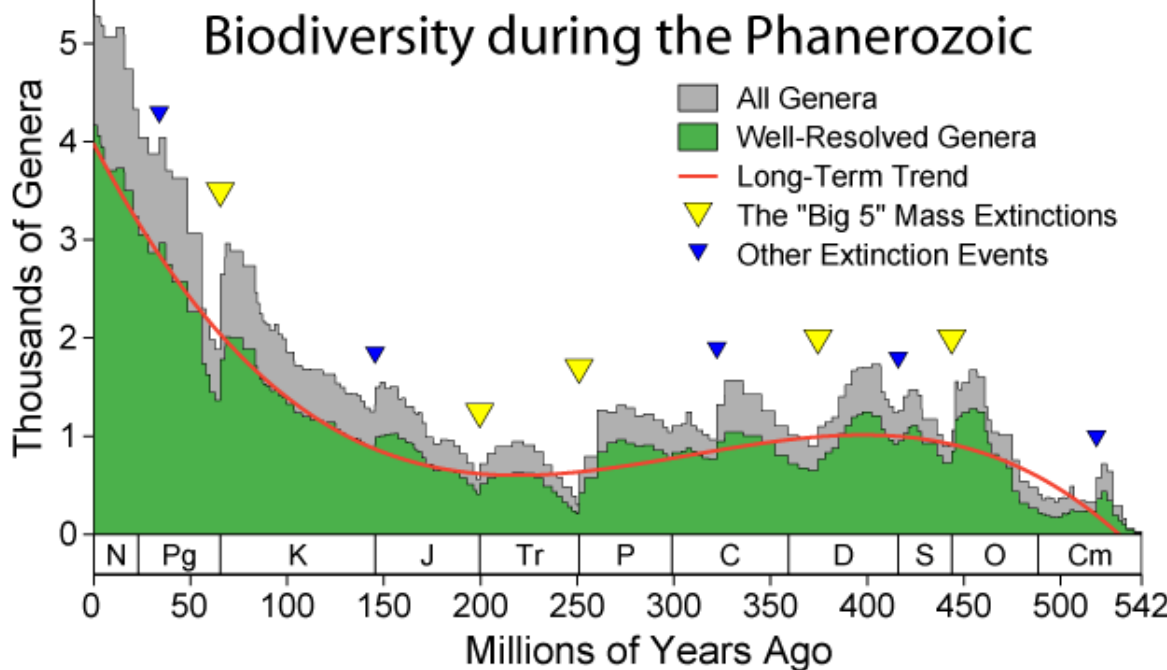
Figure 10. Global Biomass Since The